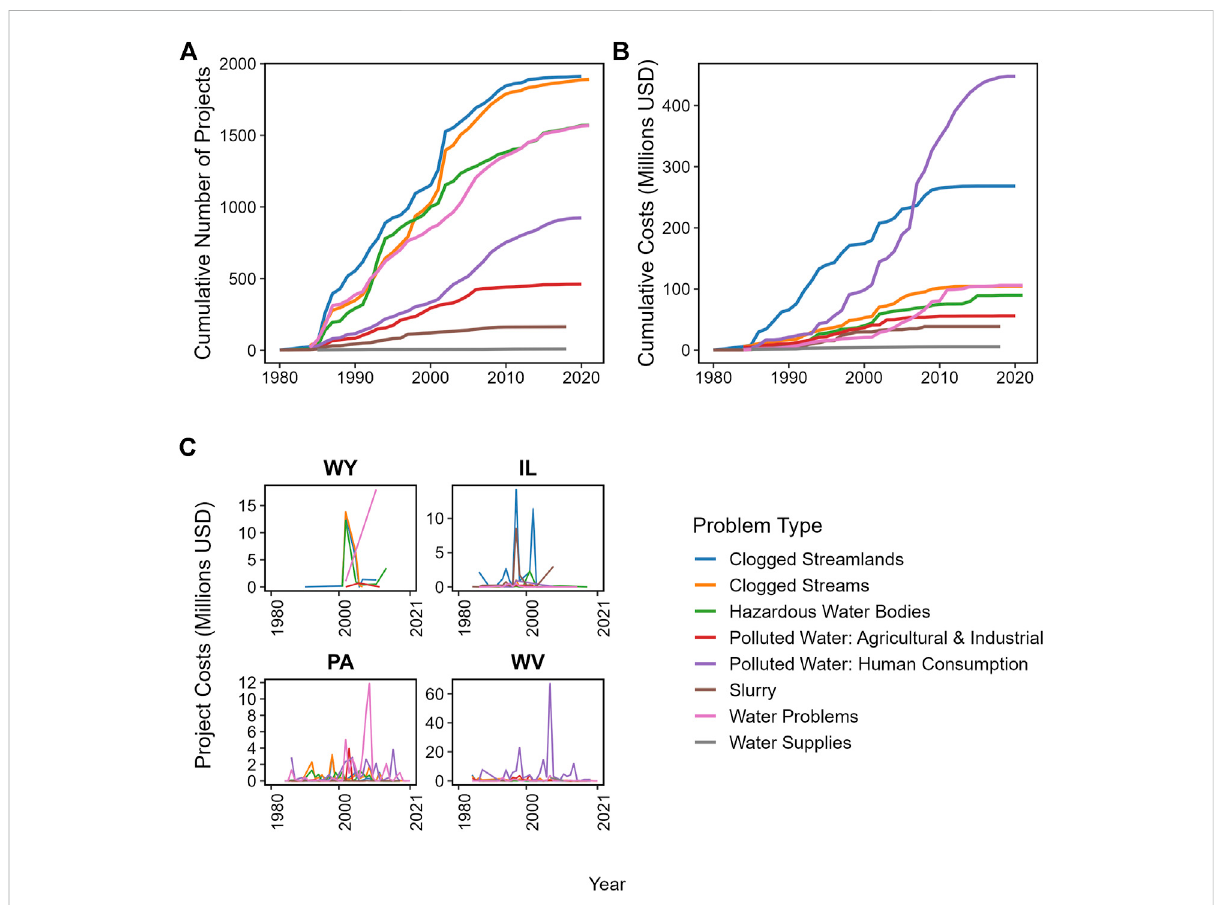
FIGURE 4 Changes in the number of projects and project costs over time under the Surface Mining Control and Reclamation Act (SMCRA). (A) gives the cumulativenumberofprojectsovertimebyproblemtype, (B) givescumulativecostsovertimebyproblemtype,and (C) givesprojectcostsovertime by problem type for the states of Wyoming (WY), Illinois (IL), Pennsylvania (PA), and West Virginia